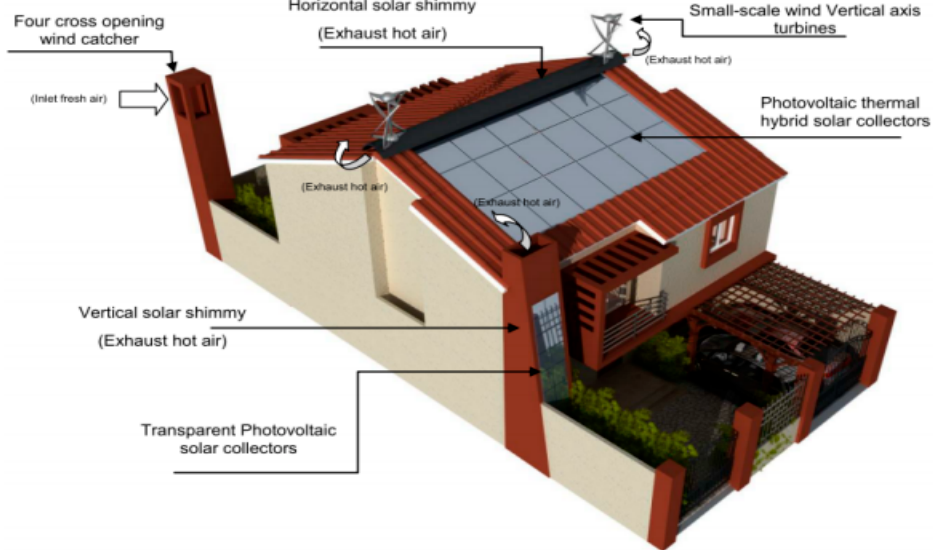
Figure 6. The integrated renewable energy system in the building [49] Copyright 2022 WIT Press .